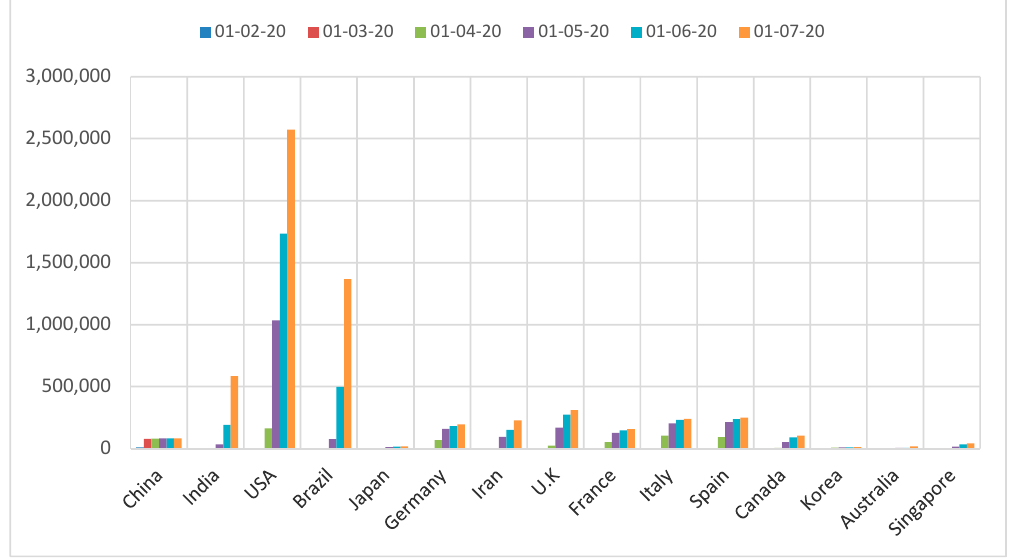
Figure 3. Change in numbers of confirmed cases over time [11–16].